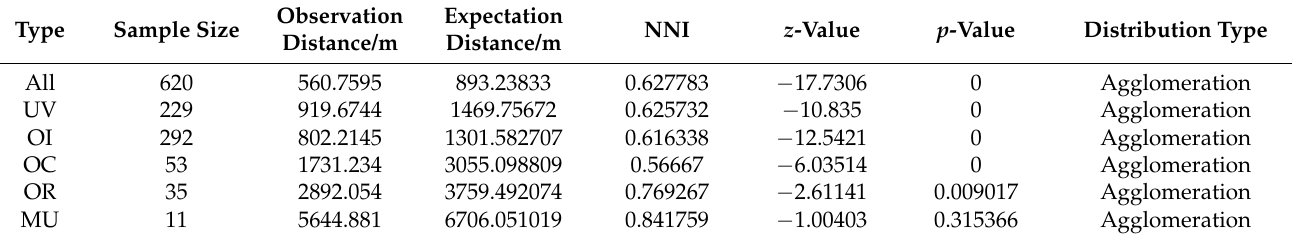
Table 3. NNI of UR projects.